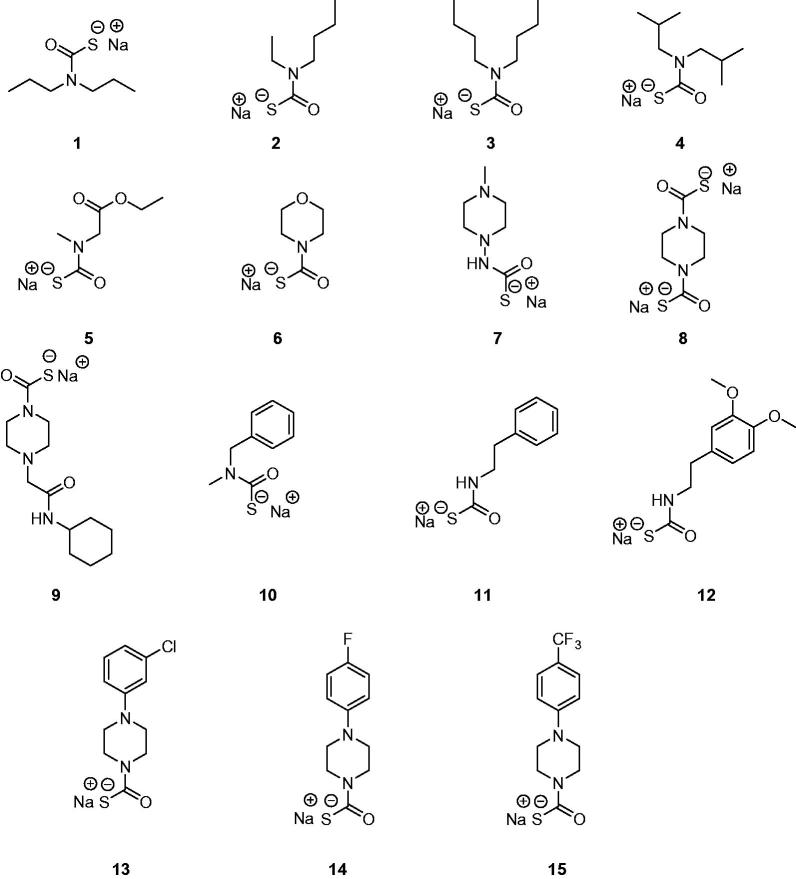
Monothiocarbamates (MTCs) 1–15 investigated as CA inhibitors4.